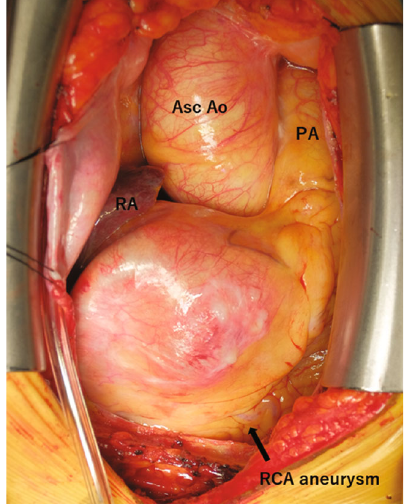
Figure 2: Intraoperative view. asc Ao: ascending aorta; PA: pulmonary